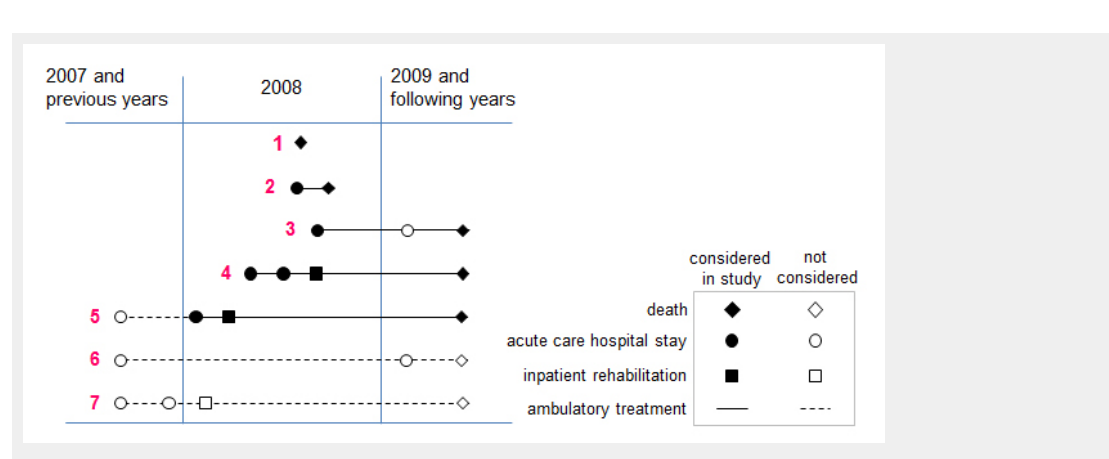
Overview of ACS events and outpatient treatments considered. The figure gives an overview of ACS events occurring in 2008 and resulting treatments. All inpatient treatments in 2008 were considered as well as outpatient treatments from ACS in 2008 until death. Remaining life years of surviving patients were modelled on age, gender and life expectancy statistics adjusted by a factor for increased relative mortality risk after an ACS. Treatments considered in the study are represented by bold icons and continuous lines, treatments not considered by light icons and broken lines. The study did not consider inpatient care provided in 2009 and following years (example 3) or possible outpatient treatment before a 1st ACS event in 2008 (example 5). Examples of sequences of ACS events: 1 – Death at 1st event in 2008 before reaching hospital.